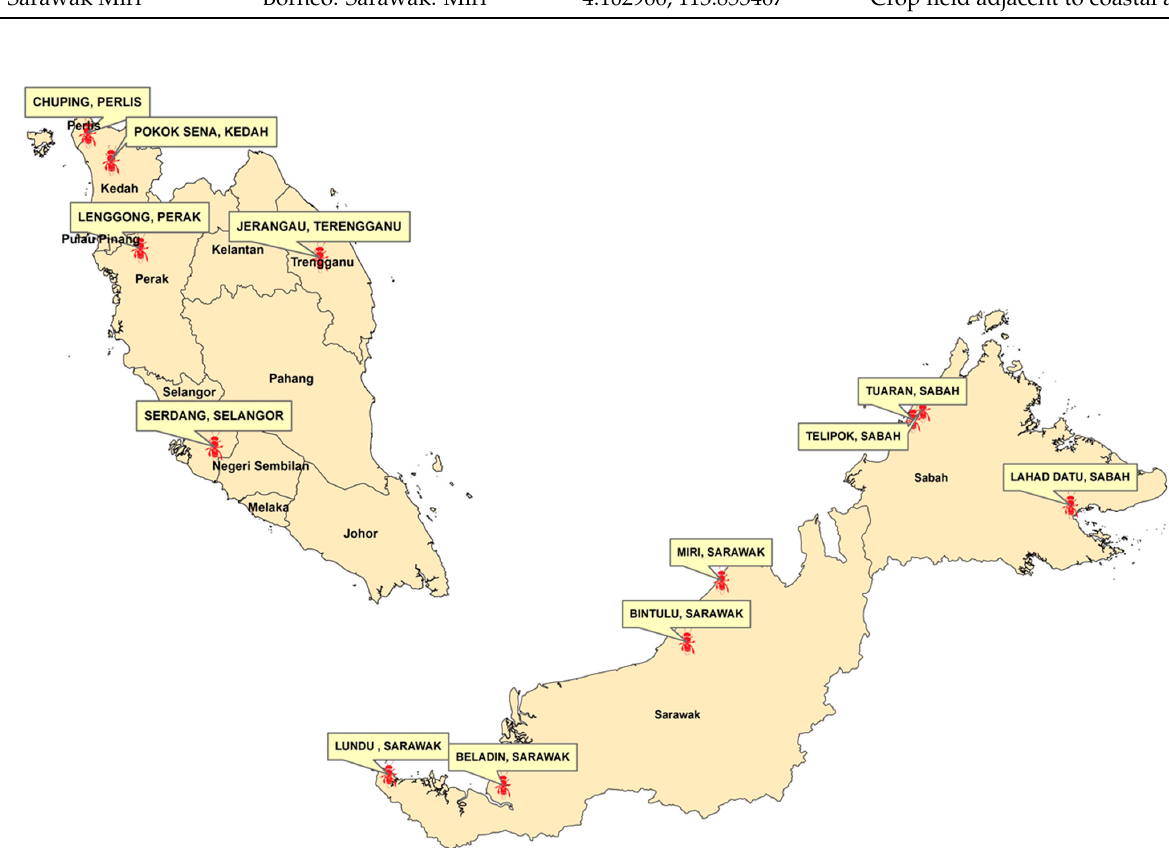
Figure 1. Collection sites of Heterotrigona itama samples throughout Malaysia.